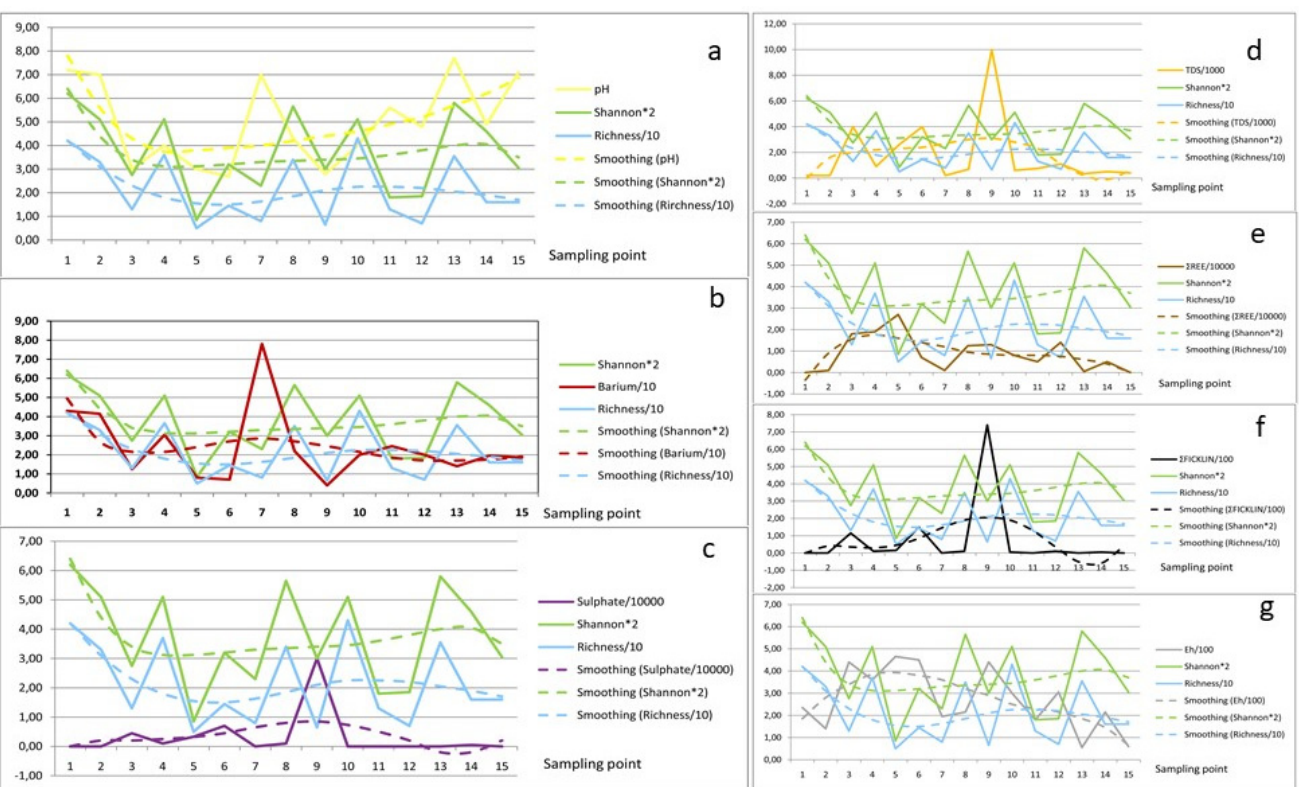
Figure 3. Spatial evolution of physico-chemical parameters: pH ( a ), barium ( b ), sulphate ( c ), TDS ( d ), ∑ REE ( e ), ∑ Ficklin ( f ) and Eh ( g ) vs. Shannon–Wiener index and richness.